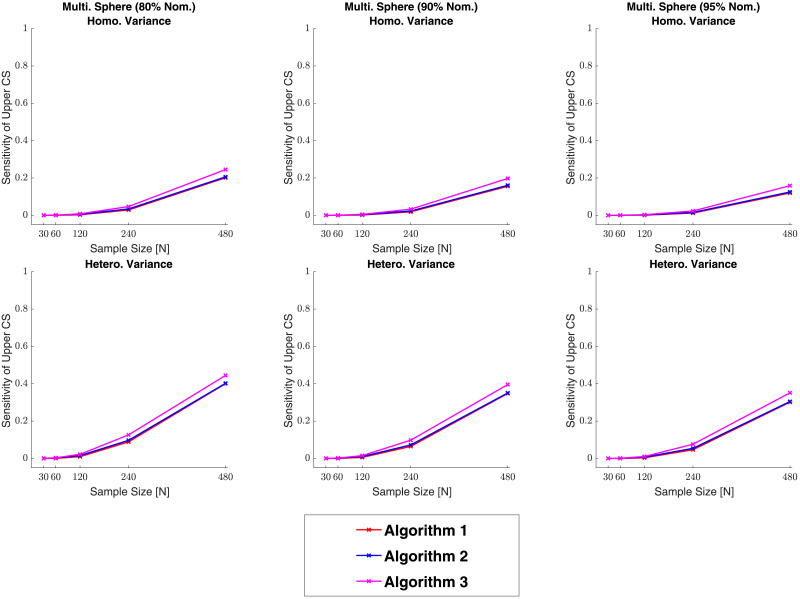
Sensitivity results for the multiple spheres signal, with homogeneous (top row) and heterogeneous (bottom row) Gaussian noise structures.